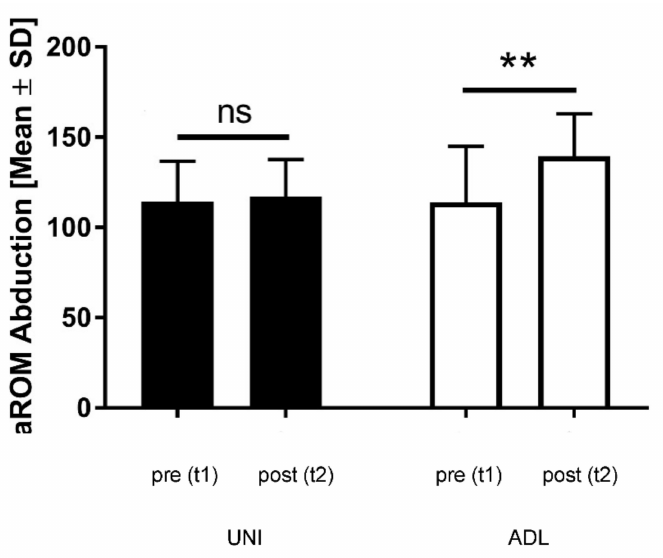
Figure 3. Shoulder abduction at t1 and t2 in the UNI-group and the ADL-group. Black columns: UNI-group; white columns: ADL-group; aROM: active range of motion; ns: not significant; Asterisks indicating significance ( p < 0.01 for **); t1: beginning of rehabilitation; t2: end of rehabilitation; SD: standard